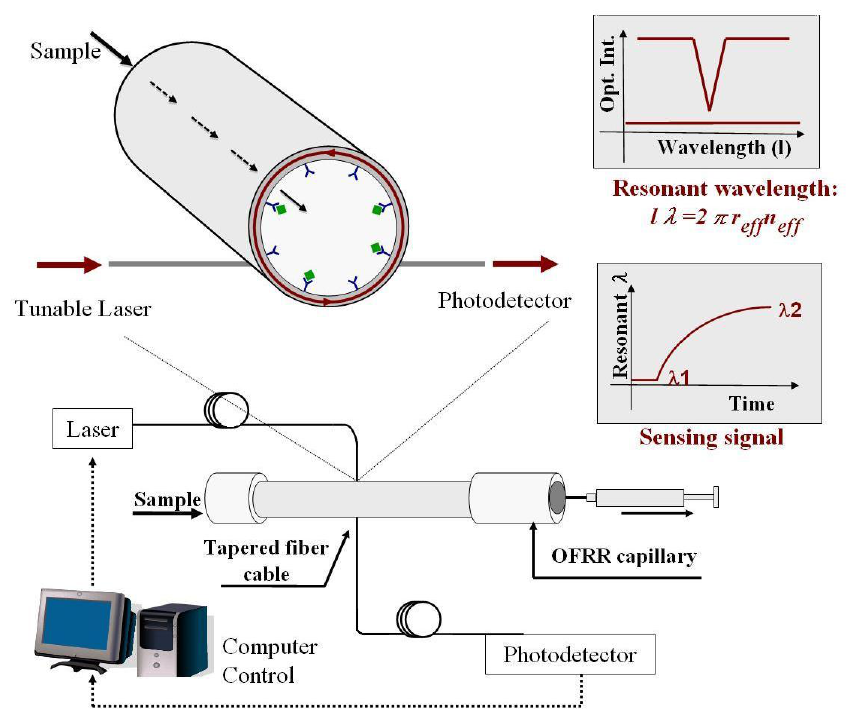
Figure 1. Schematic of the OFRR, sensing signal and experimental setup for cell